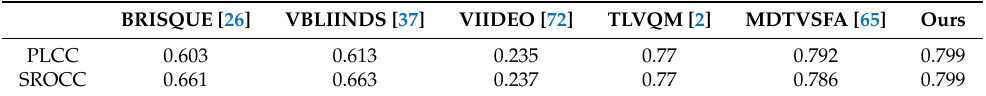
Table 4. General performance comparison with state-of-the-art on CVD2014, KoNViD-1k, and LIVE-Qualcomm.